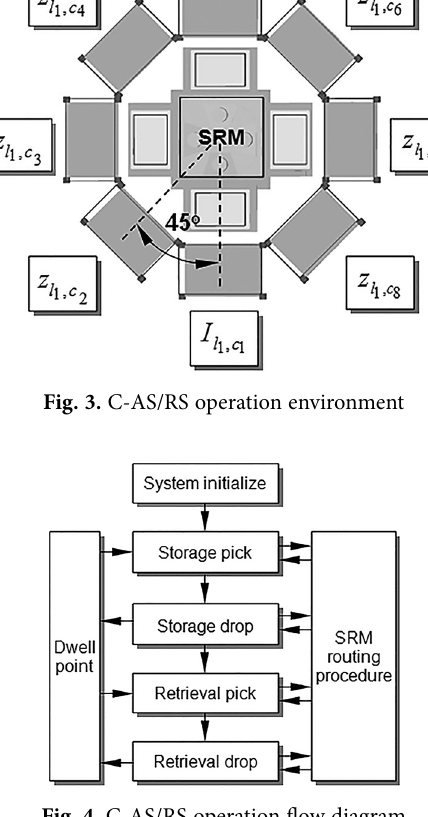
Fig. 4. C-AS/RS operation flow